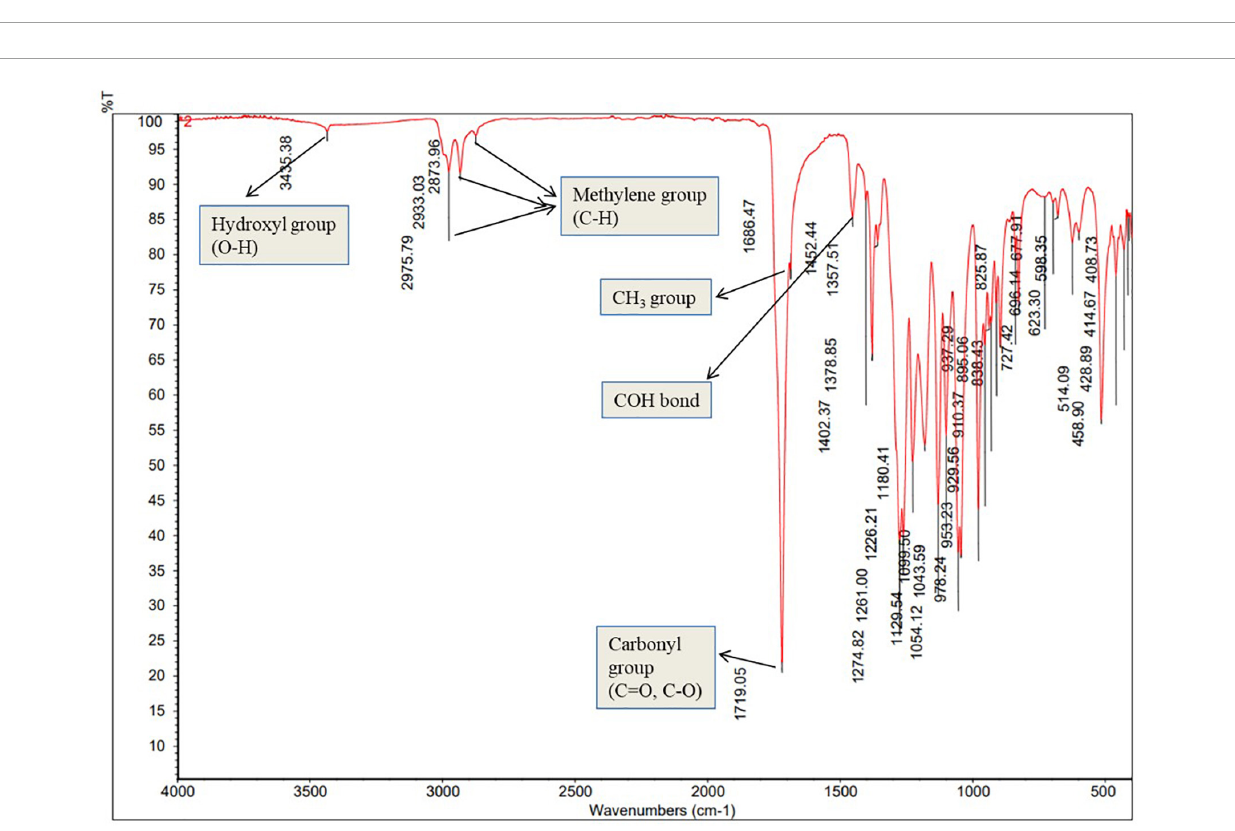
FIGURE6 Fourier transform infrared analysis of polyhydroxybutyrate polymer extracted from strain RG36 T grown in medium containing glucose as carbon source.